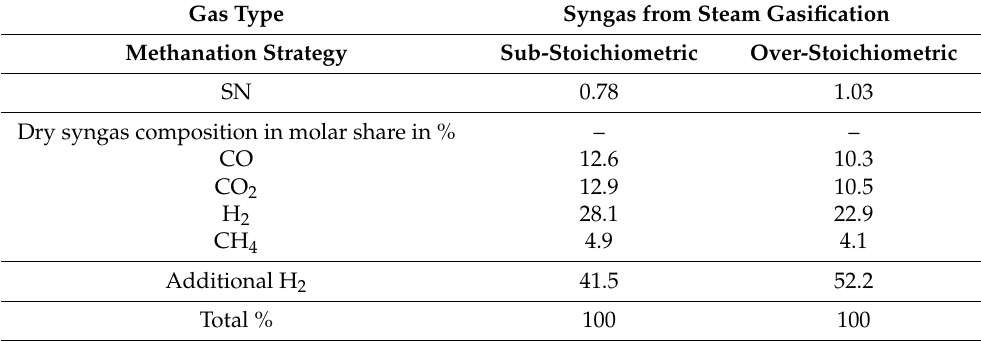
Table 3. Steam gasification syngas composition used for experimental lab ‐ scale methanation test runs at 7 bar and at GHSV = 2000 h − 1 . Hydrogen included in the syngas and additional supplied hydrogen are indicated.